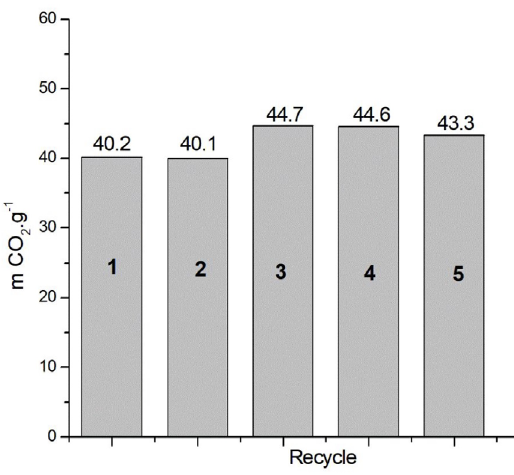
Figure 8. Recycle test: five sorption/desorption cycles applied to the sample A-mbmim[Tf 2